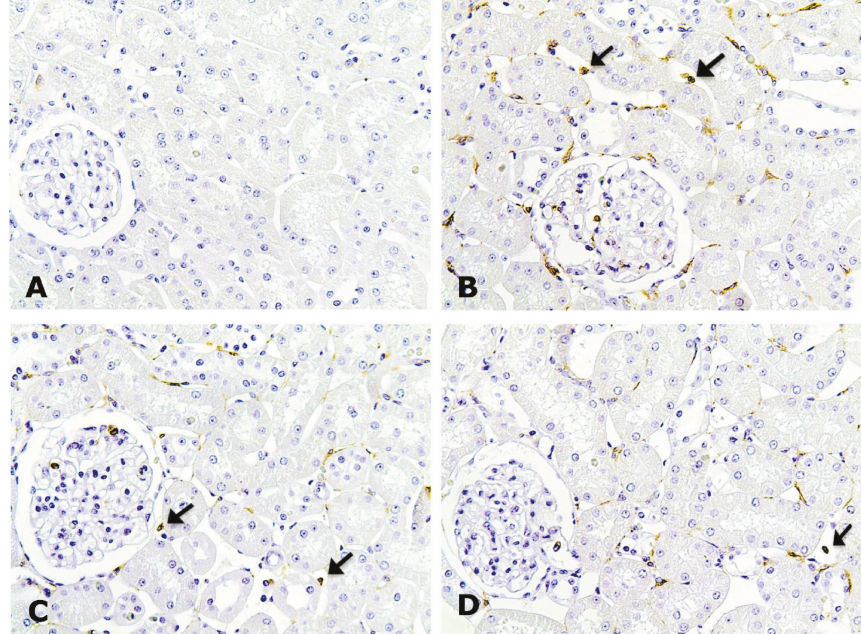
Figure 2: Immunolocalization of CD43 in the renal cortex of SC (a), SD (b), TD (c), and PTD (d) rats. Note the less intensity of CD43 immunostainings in PTD. Original magni fi cation ×